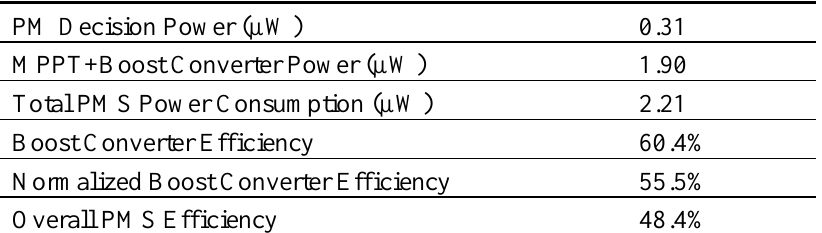
Figure 12. Measured efficiency of boost converter and overall PMS block. Table 3. Performance summary in energy harvesting